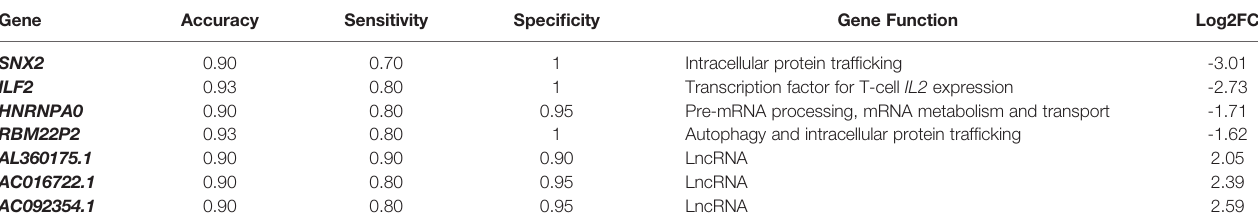
TABLE 3 | Quality parameters of univariate Logistic Regression analysis